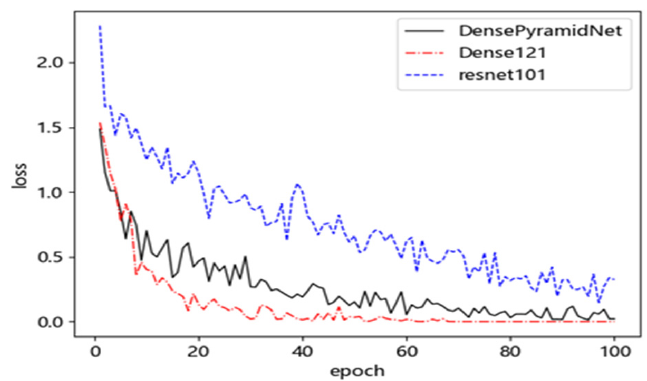
Figure 12. Training loss of three algorithms on cifar10.